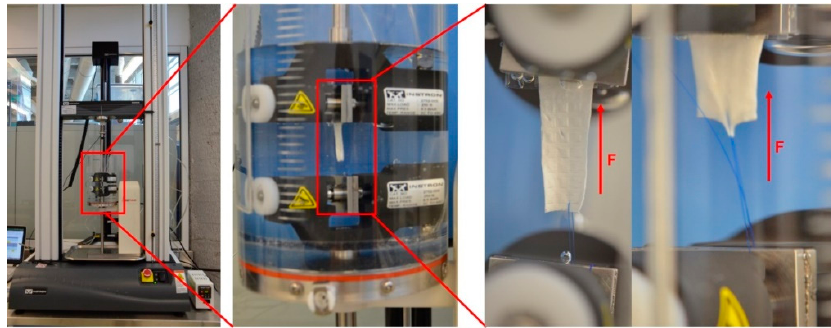
Figure 12. Set up used for mechanical characterization.